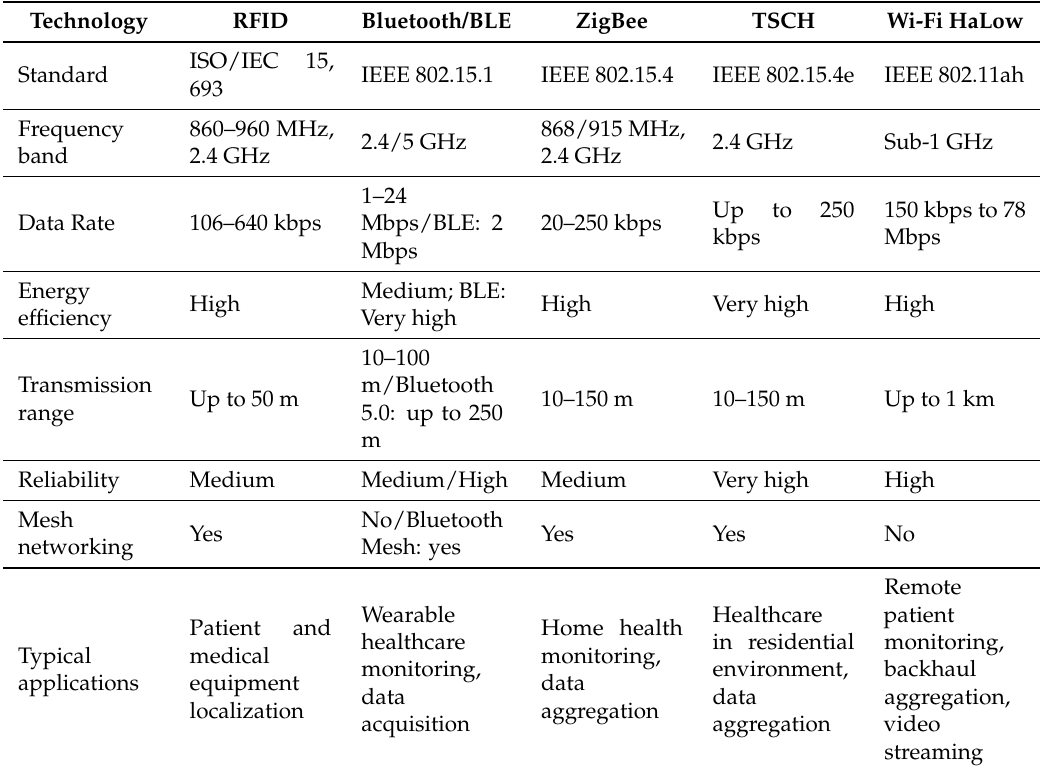
Table 1. Low-power wireless technologies for smart